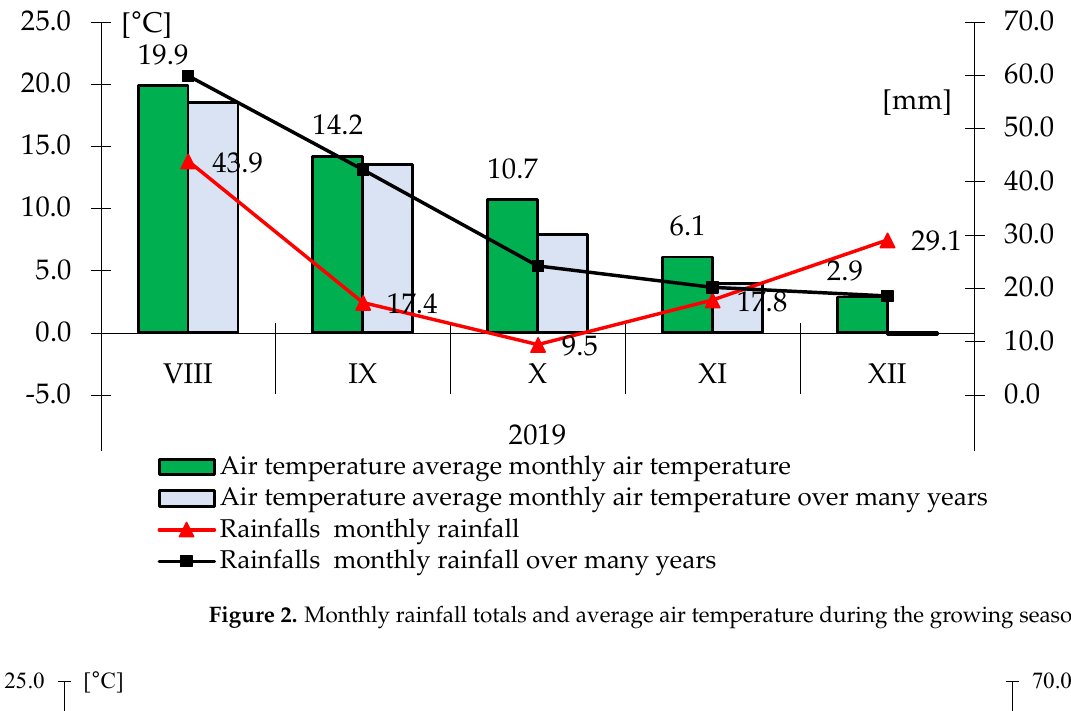
Figure 2. Monthly rainfall totals and average air temperature during the growing season 2019.